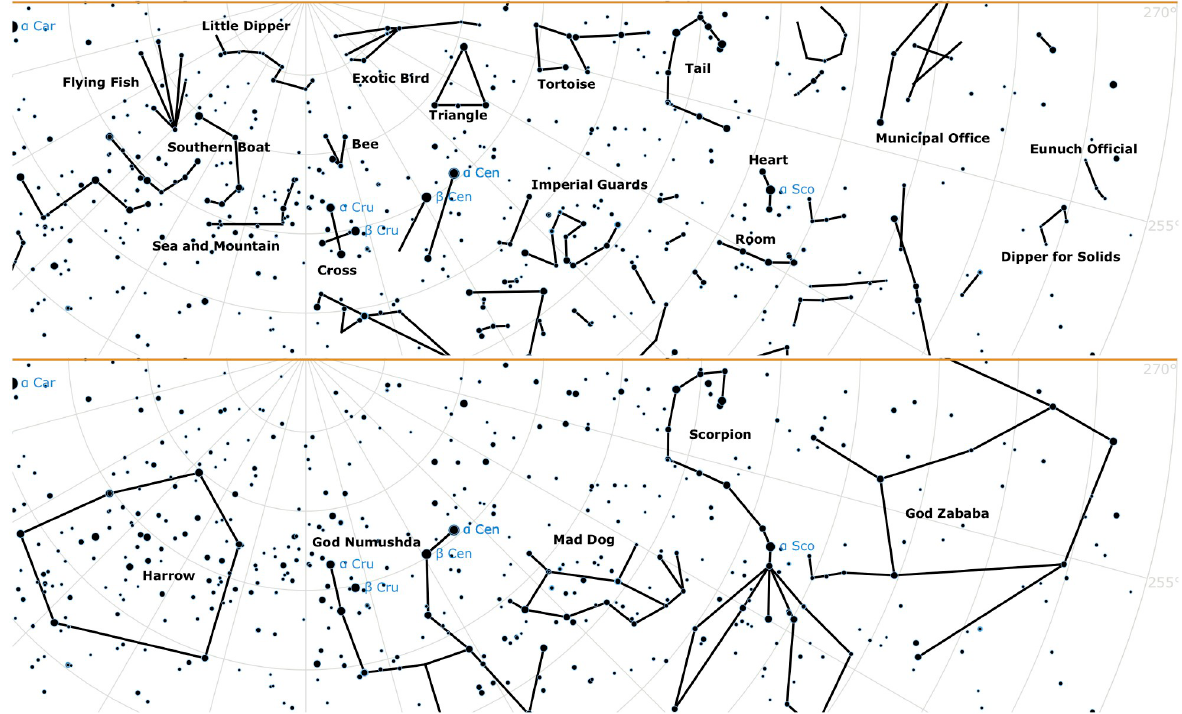
Fig 1. The diversity of constellations line figures. Traditional Chinese (top) and ancient Babylonian (bottom) constellations for the same southern sky: declinations [ − 90˚, 20˚], right ascensions [90˚, 270˚]. The choice of stars and lines differs. Some constellation names removed for clarity.